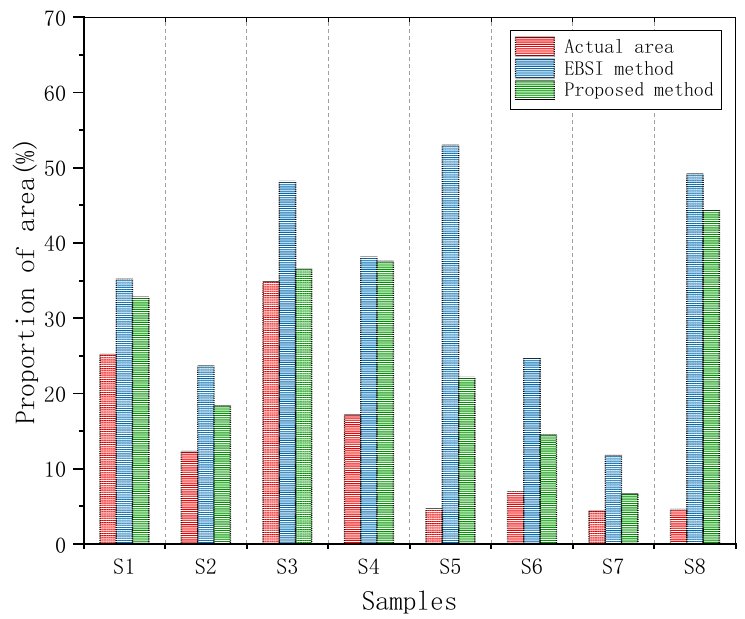
Figure 11. Proportion of defective area from the reconstructed images using different methods for all samples.